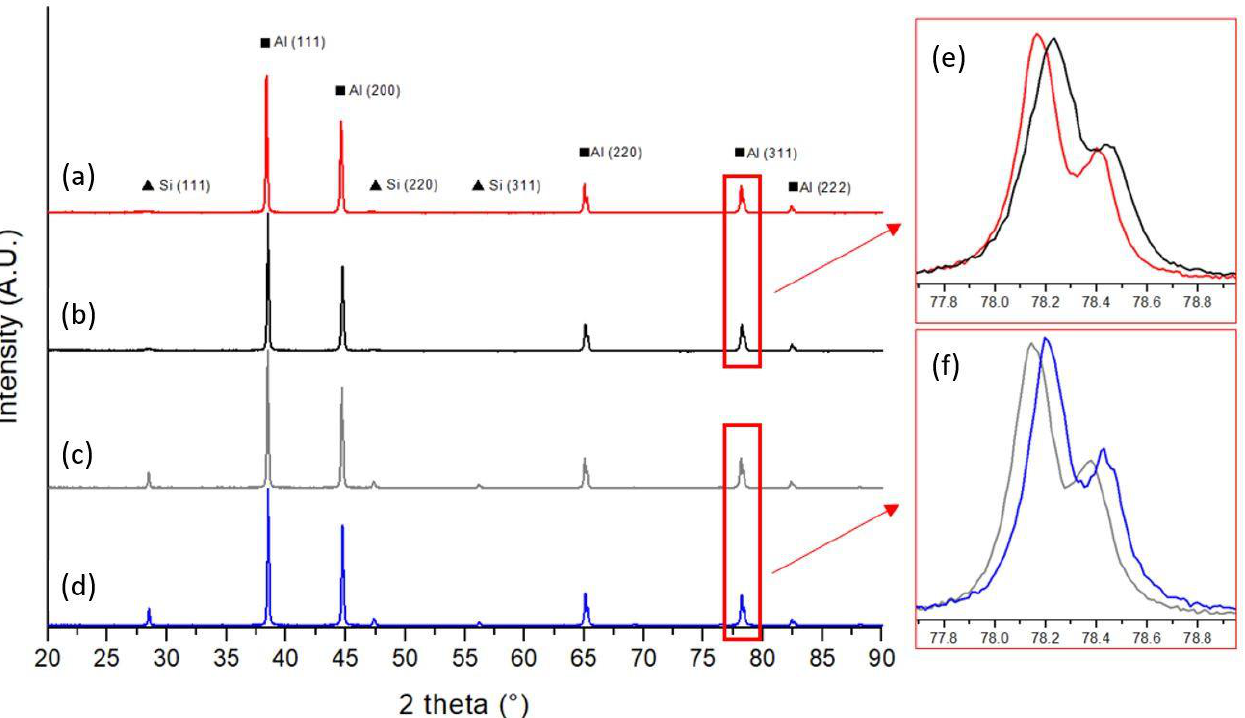
Figure 4. XRD patterns of ( a ) AB, ( b ) DA-6, ( c ) S-SHT, and ( d ) S-T6-6 samples and inset of ( e ) AB and DA-6 and ( f ) SSHT and S-T6-6 samples.